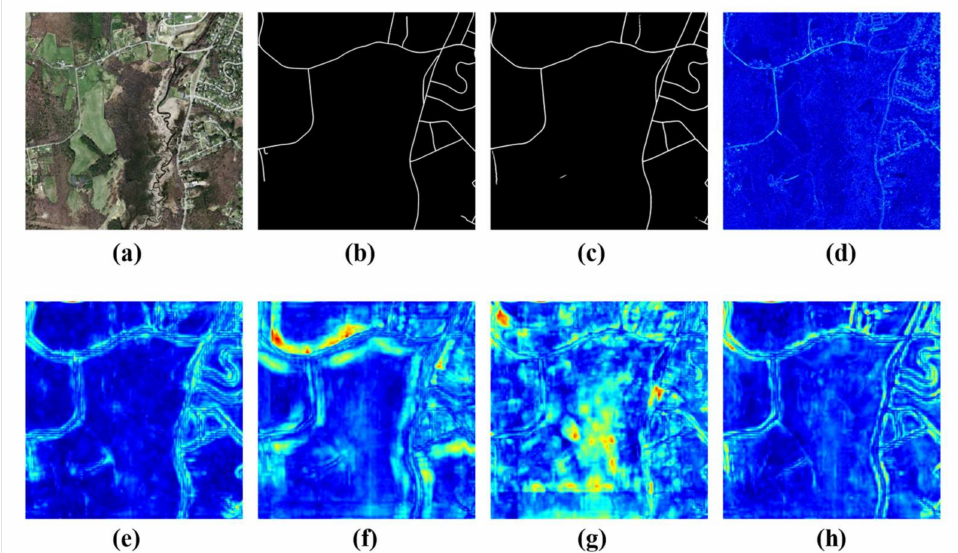
Figure 9. Analysis of attention heat map of the patch from different scales. ( a ) The test image. ( b ) The ground truth. ( c ) Results with HA-RoadFormer. ( d ) the heat map of the attention feature matrix in the second stage of HA-RoadFormer. ( e ) the heat map from the small-scale branch. ( f ) the heat map from the medium-scale branch. ( g ) the heat map from the large-scale branch. ( h ) the heat map of the feature fusion of three different branches.